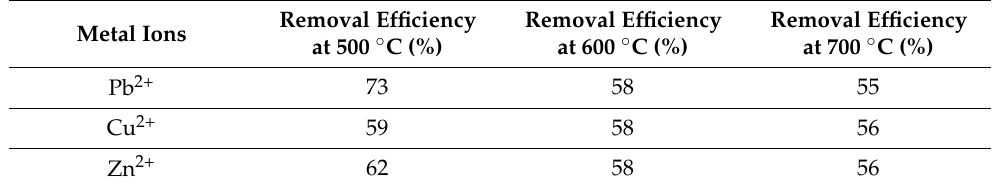
Table 8. Metal ion removal efficiency of adsorbent pre-functionalization thermally treated at 500 ◦ C, 600 ◦ C, and 700 ◦